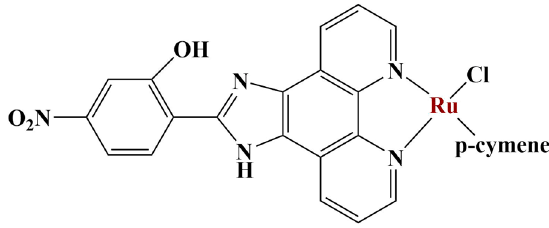
Figure 16. The most active complex presented in [62].